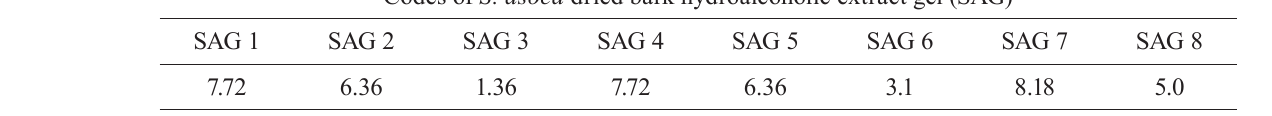
Rate of Permeation (%)